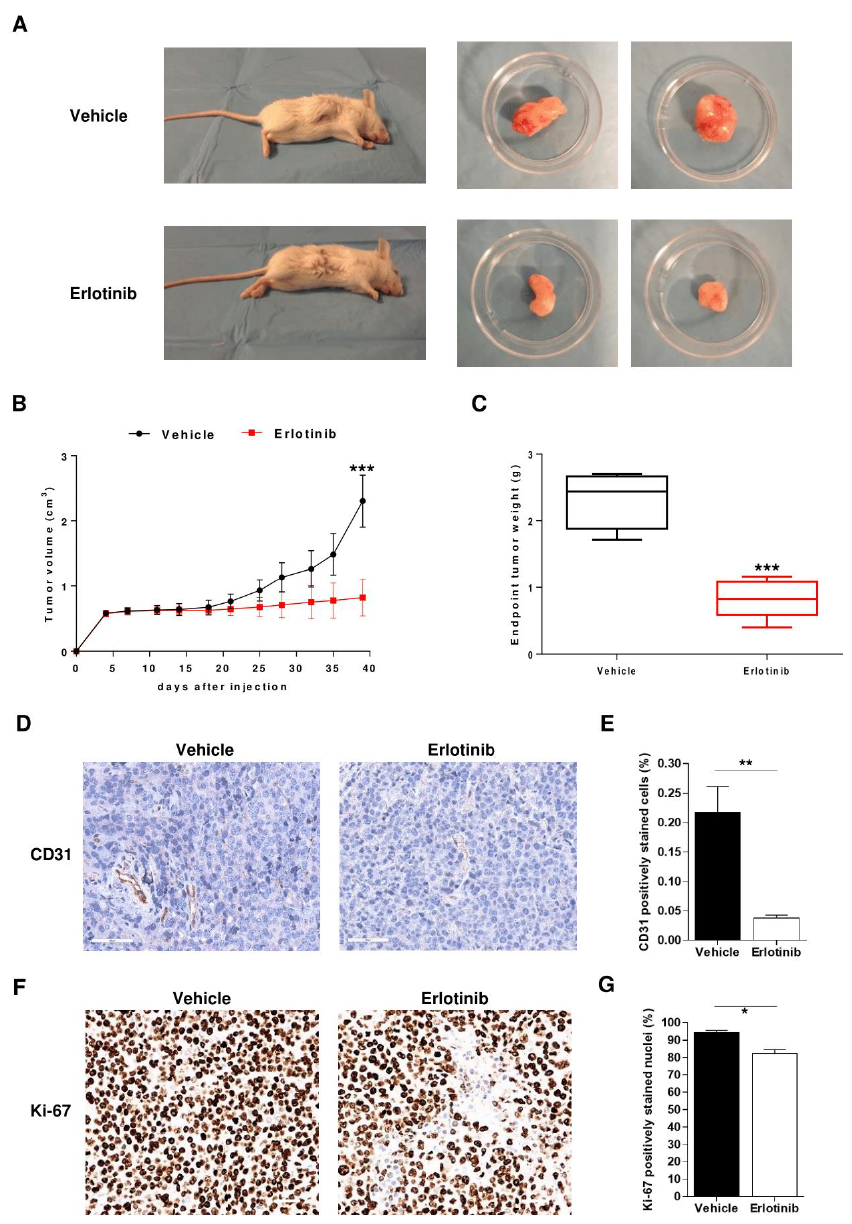
Figure 6. Erlotinib halts in vivo angiogenesis and suppresses tumor growth in an MM xenograft mice model. Non-obese diabetic mice with severe combined immunodeficiency (NOD / SCID) bearing RPMI 8226 xenografts were treated intraperitoneally with 50 mg / kg erlotinib ( n = 10) or vehicle ( n = 10). ( A ) Representative images of mice and excised tumors. ( B ) Change in tumor volume over time. ( C ) Estimated weights of excised tumors on day 40. Data are expressed as median, interquartile range (box), and range (whiskers). ( D , E ) Tumor sections stained for the microvessel density marker CD31 and quantification of positively stained murine endothelial cells. ( F , G ) Tumor sections stained for the proliferative marker Ki-67 and quantification of positively stained nuclei. Immunohistochemical images were analyzed by two independent pathologists in a blind fashion. Immunohistochemical quantifications are the average of five slides for each tumor and five fields per slide. * p < 0.05, ** p < 0.01, *** p < 0.001, Mann – Whitney U test.